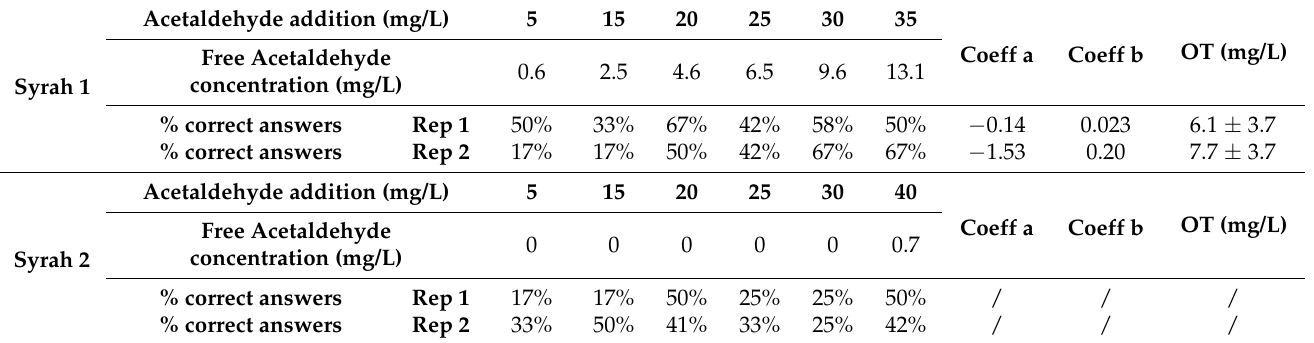
Table 4. Sensory thresholds for acetaldehyde for the Syrah red wine samples. Values represent means of triplicate determination ± standard